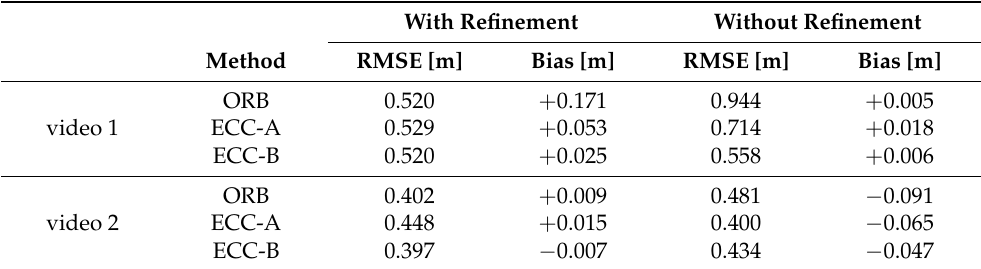
Table 4. RMSE and bias of the inferred bathymetry for different GCP-tracking methods. With Refinement Without